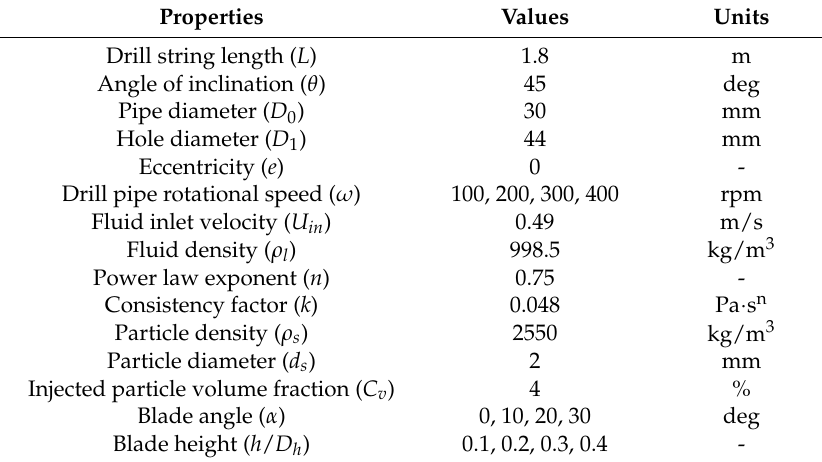
Table 1. Summarized input parameters in the